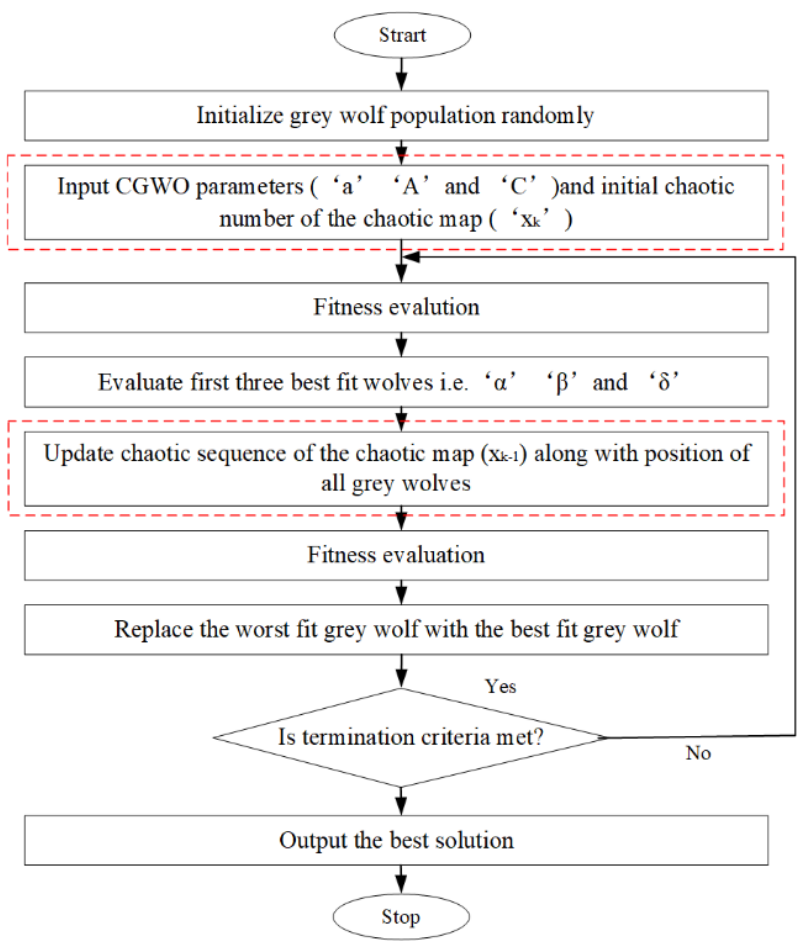
Figure 1. Flow chart of grey wolf optimizer algorithm.